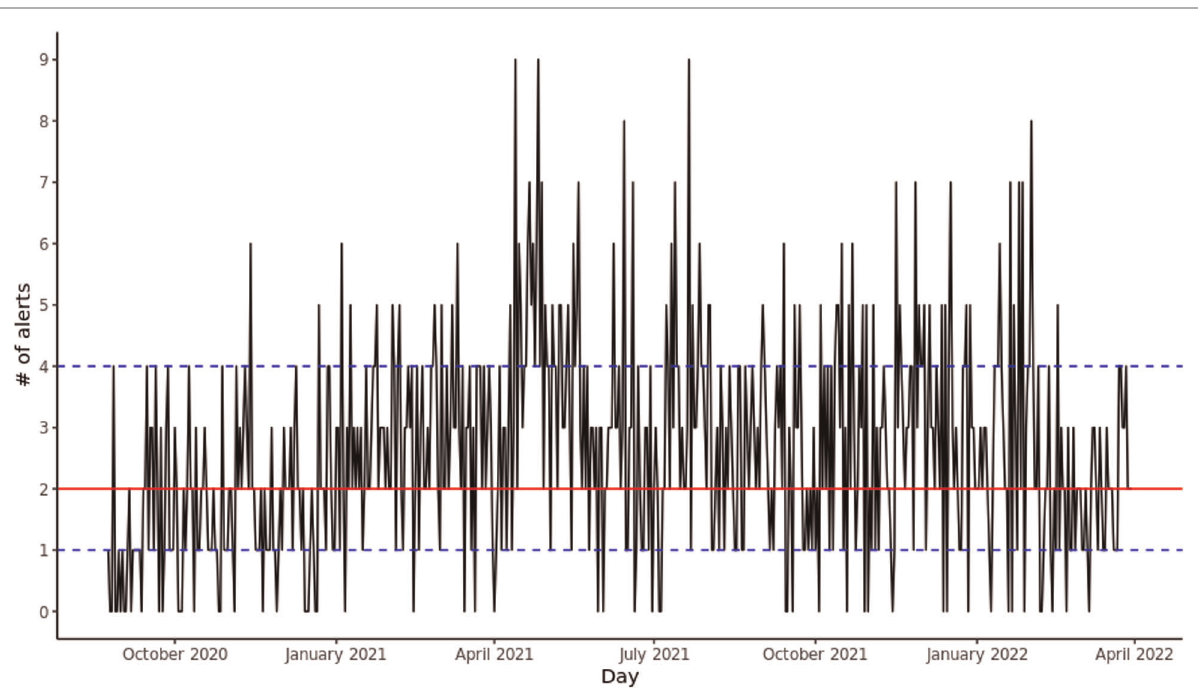
FIGURE 1 Daily alerts sent by CHARTwatch. The red solid line indicates the median number of daily alerts. The blue dashed lines indicate the 25th quantile and the 75th